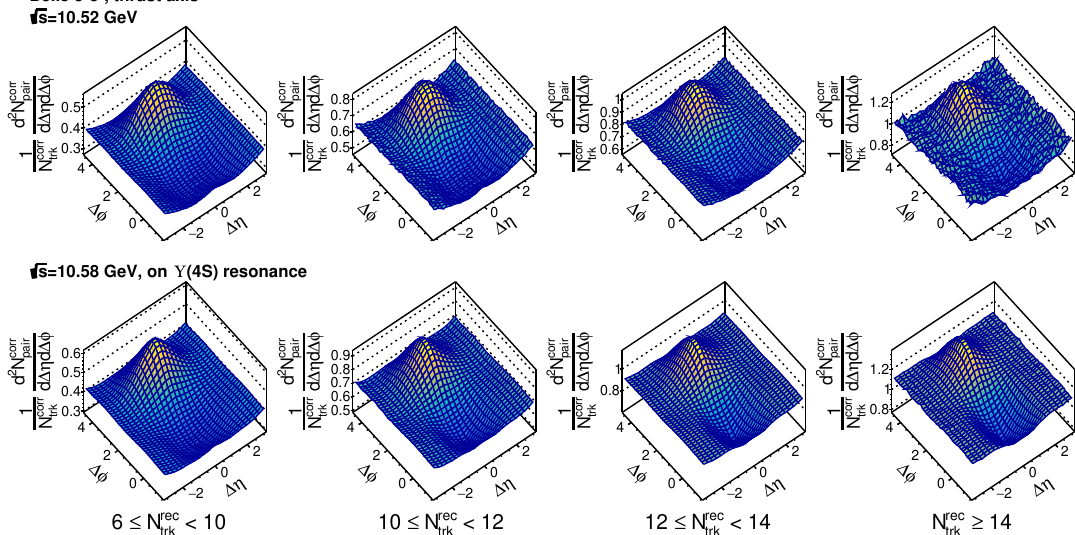
Figure 6. Thrust-axis two-particle correlation functions for the off-resonance (top) and on-resonance (bottom) data versus the reconstructed-track multiplicity N rec intervals from left to